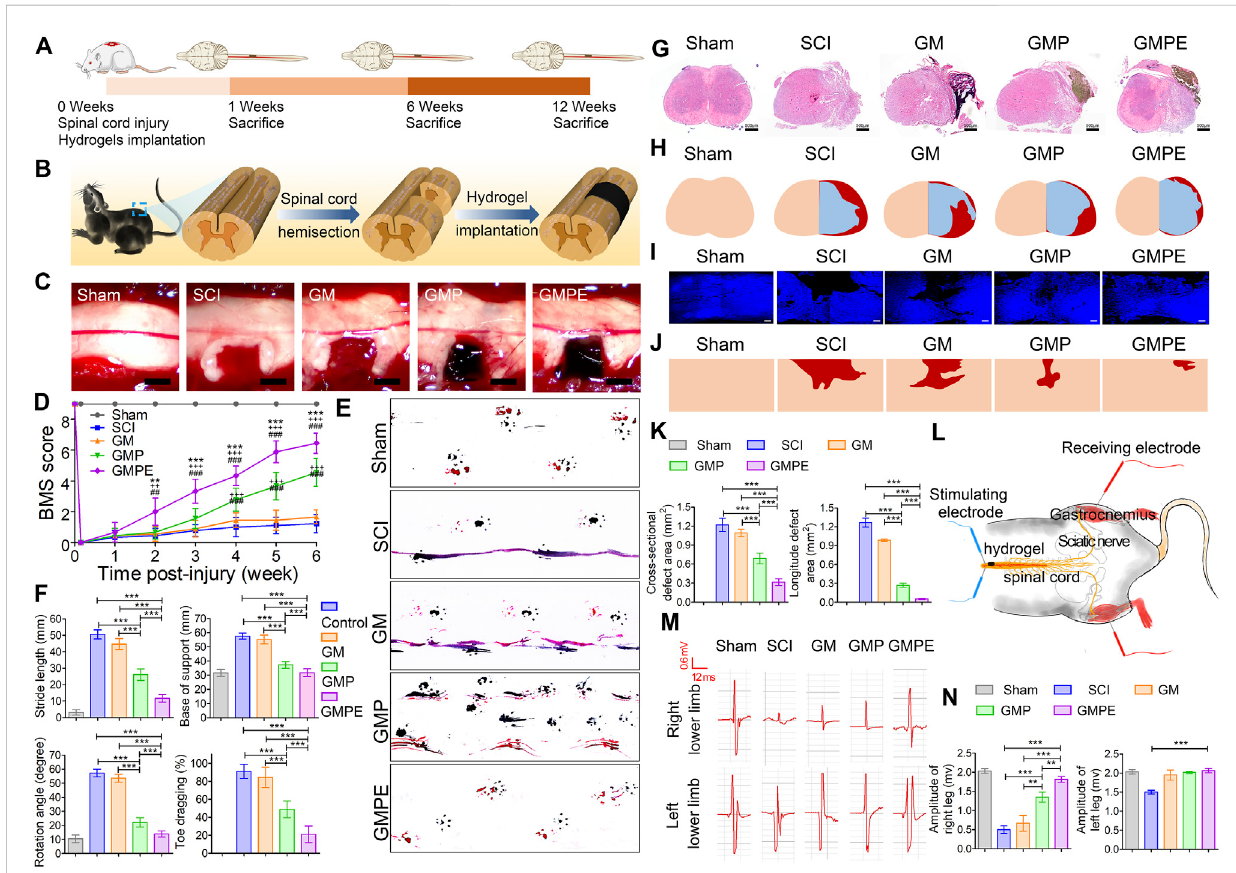
FIGURE 2 Functional recovery of mice in each subgroup. (A) Schematic diagram of the experimental timeline. (B) Demonstration of spinal cord hemisection andhydrogel implantation. (C) Implantation ofdifferenthydrogelsinthecavity site. (D) BMSscore toassessmotorrecovery oftherighthindlimbinmice. ComparedtoGMP(* p < 0.05,** p < 0.01,*** p < 0.001)andGM(+ p < 0.05,++ p < 0.01,+++ p < 0.001)hydrogelsandSCI(# p < 0.05,## p < 0.01,### p < 0.001), GMPE hydrogel-treated mice had improved BMS motor scores (n = 9). (E) Recovery of motor function was assessed by footprints. Blue represents forelimb footprints and red represents hindlimb footprints. (F) Step length, point of support, rotation angle and toe drag were quanti fi ed to assessmotorrecovery6weekspost-injury(n=9). (G) HEstainingshowingthemorphologyoftransversespinalcordsectionsafterhydrogelimplantation. (H) Representative reconstruction of the spinal cord cross-sections. The color of normal tissue was fresh, the color of cavity was red, and the color of regenerated tissue was blue, respectively. (I) Immuno fl uorescence images demonstrating the morphology of longitudinal sections of the spinal cord. (J) Images of reconstructed longitudinal sections of the spinal cord. Skin tones and red areas represented normal tissue and cavity areas, respectively. (K) Quanti fi cation of cavity volumes in transverse and longitudinal sections of the spinal cord (n = 3). (L) CMAPs testing protocol for mice in the GMPE hydrogeltreatmentgroupwasshown. (M) CMAPsresultsformiceinthenormalgroupandvarioushydrogelsimplantedfor6weeks. (N) Quanti fi cationof the CMAPs amplitudes measured in mice of the sham and hydrogel treatment groups (n = 3). Reprinted with permission from Fan,L.; Liu,C.; Chen,X.; Zheng,L.; Zou,Y.; Wen,H.; Guan,P.; Lu,F.; Luo,Y.; Tan,G.; Yu,P.; Chen,D.; Deng,C.; Sun,Y.; Zhou,L.; Ning,C. (2022). Copyright 2022 Advanced Science, Wiley-VCH GmbH (Fan et al.,